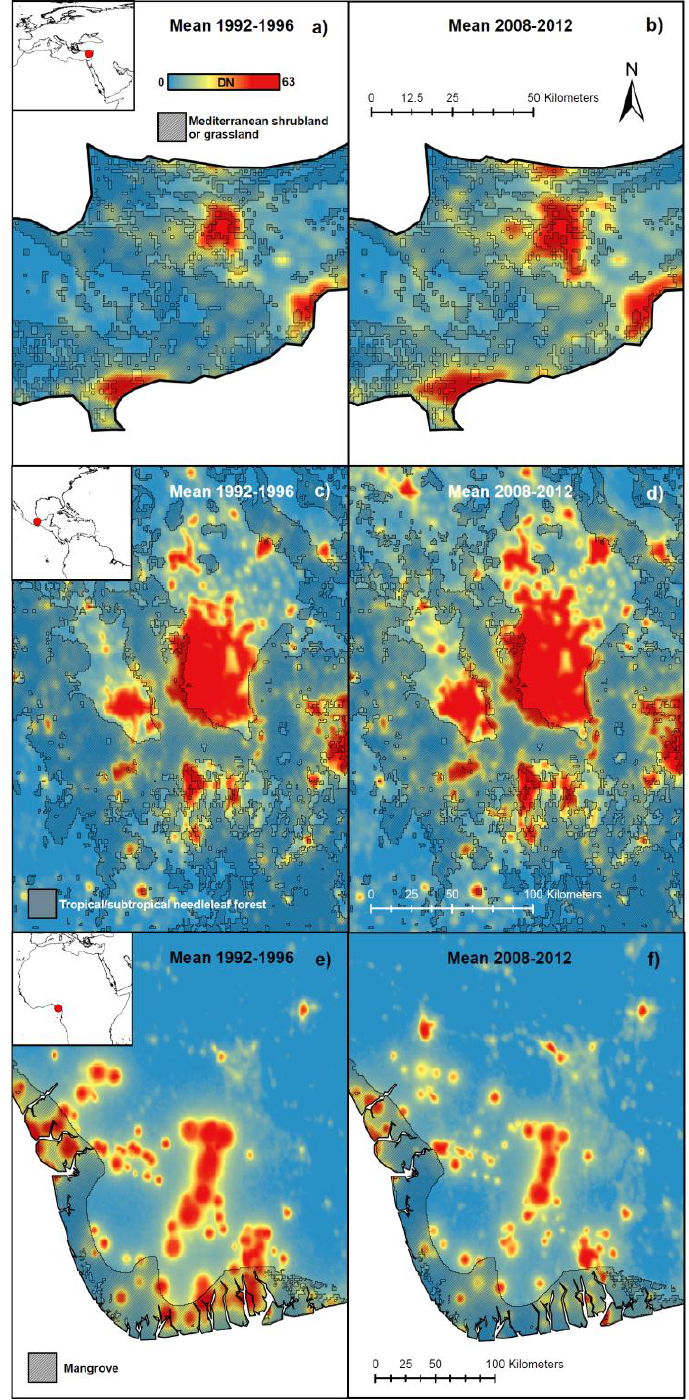
Figure 3. Selected regions illustrating encroachment of light onto natural and semi-natural ecosystems. ( a , b ) central Cyprus, with colour shading representing light intensity from intercalibrated DMSP/OLS data from ( a ) 1992–1997 and ( b ) 2008–2014. Cross hatched area shows the distribution of Mediterranean grassland or shrubland; ( c , d ) central Mexico, including Mexico City, for the same time periods. Cross hatched area shows the distribution of subtropical needleleaf and mixed forest; ( e , f ) the Niger Delta, Nigeria, showing the changing patterns of light emission due to changes in activity in the oil industry. Cross-hatched area shows the extent of coastal